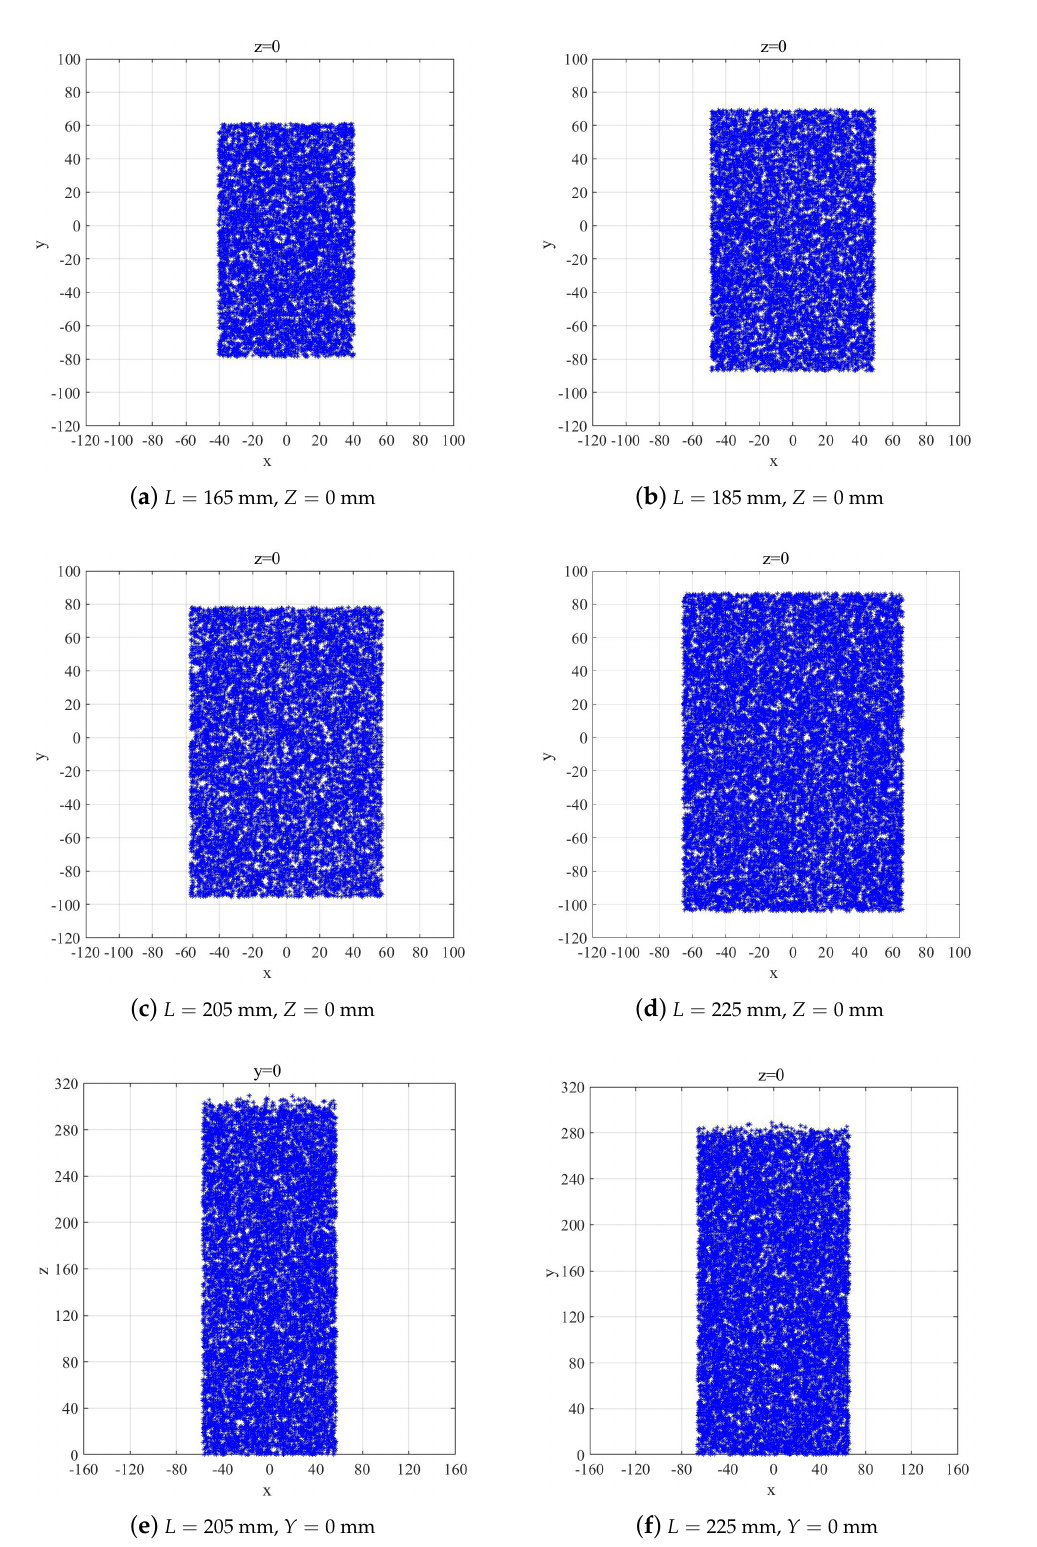
Figure 13. Limitation of link length